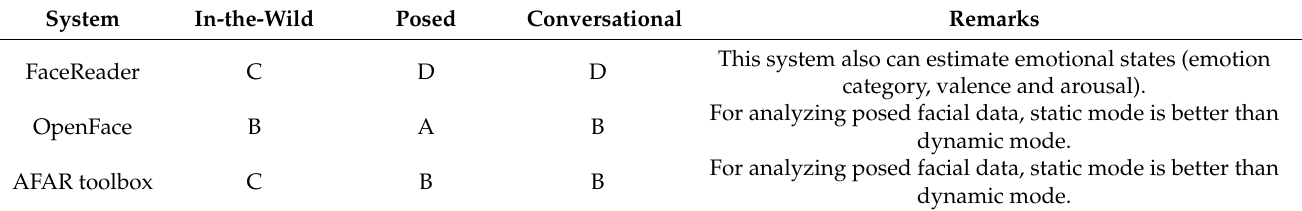
Table 5. Overview of the results of the current study. A, average AUC score > 0.80; B, average AUC score = 0.71–0.80;